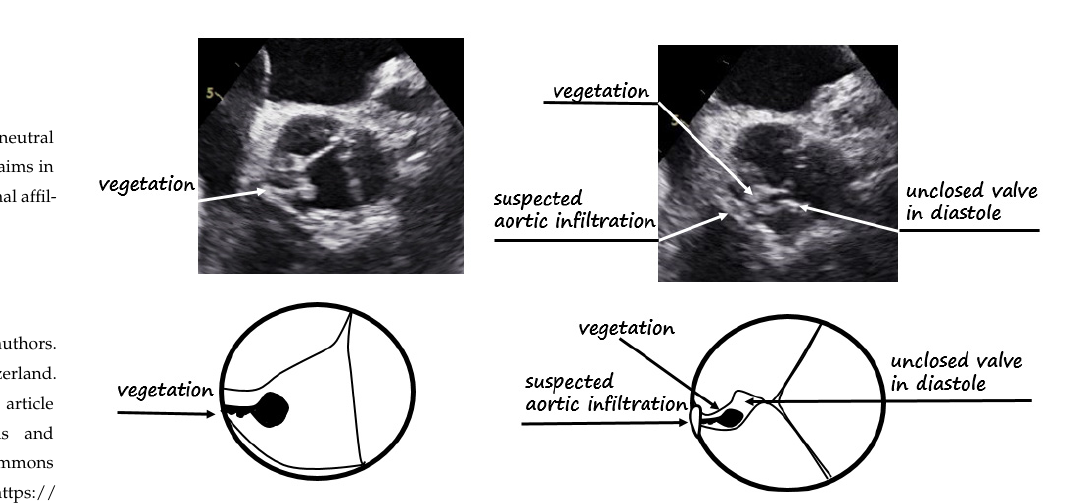
Figure 1. First TEE at the time of acute aortic regurgitation presentation. Top left panel shows TEE at level of aortic valve; a shaggy, pedunculated mass [1] is attached to the aortic wall; bottom left panel shows the relative scheme. Top right panel shows TEE at same level in diastole, with vegeta- tion impeding correct valve closure and a suspected aortic wall infiltration; bottom right panel shows the relative pictogram. Figure 2. Second TEE, 7 days later. Top left panel shows aortic wall abscess [2]; bottom left panel shows the relative scheme. Top right panel shows TEE at same level with color Doppler, demon- strating a little aortic to the right of the atrium shunt; bottom right panel shows the relative picto- gram.